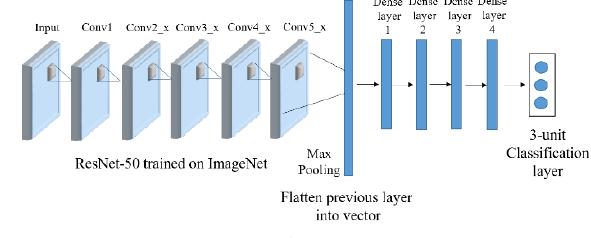
Figure 2. Structure of the proposed CNN